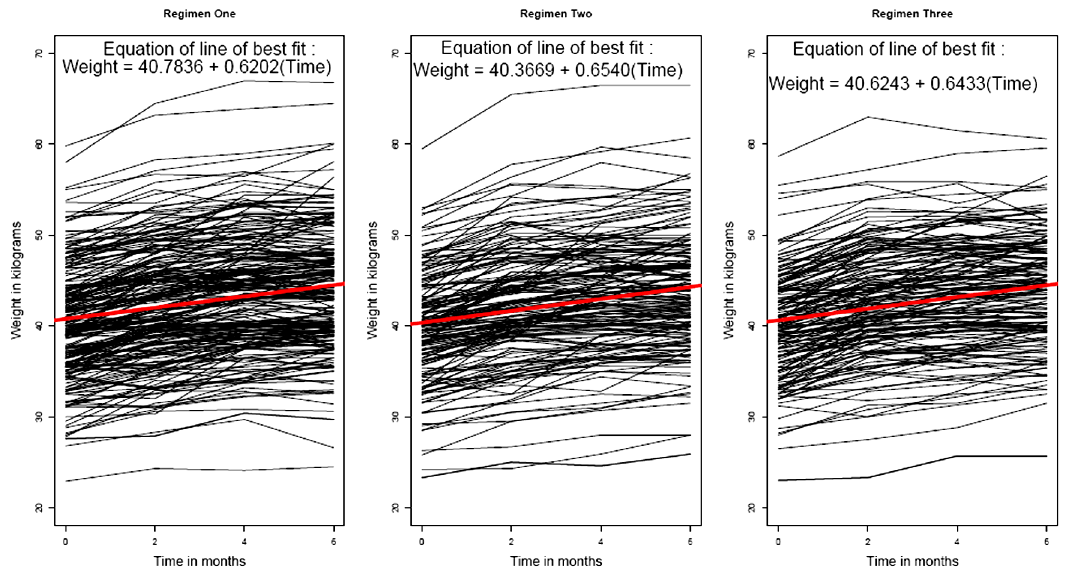
Figure 2. Scatter line diagram of weight of TB patients (in kilograms) versus time (in months) according to regimen. Legend: Black lines - weight of TB patients. Red line - line of linear regression.